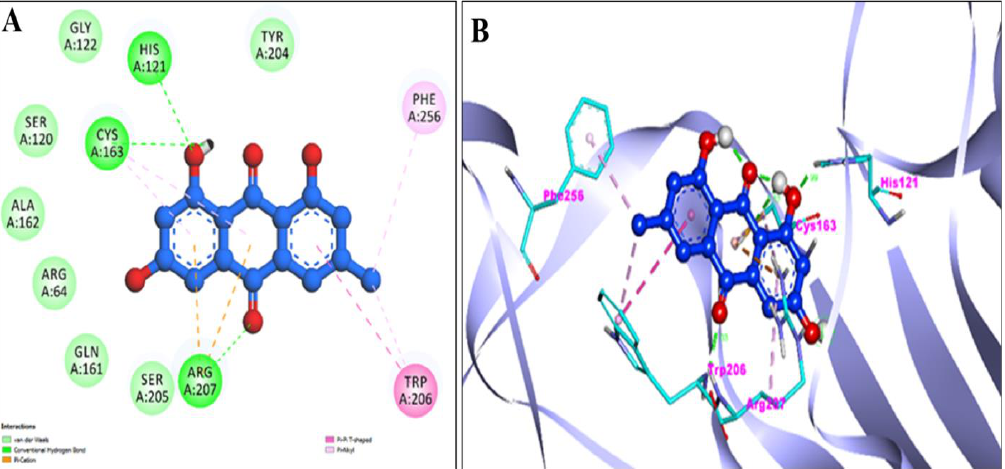
Figure 3. 2D ( A ) and 3D ( B ) representation of interaction of emodin (blue color) and caspase-3 protein (purple color with ribbon pattern) (PDB:4QU8).